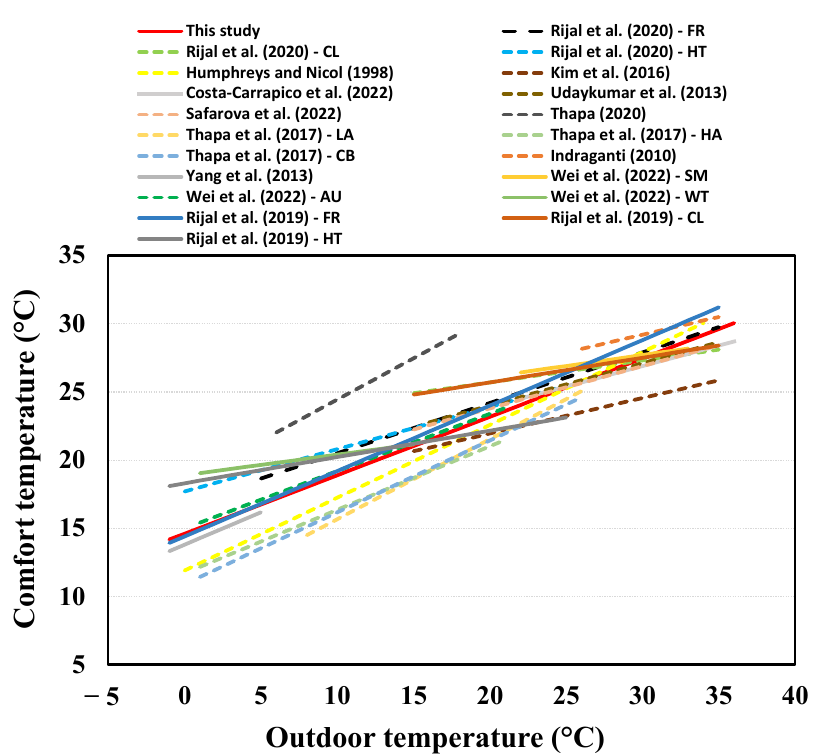
Figure 10. Regression line for comfort temperature with outdoor temperature ranges